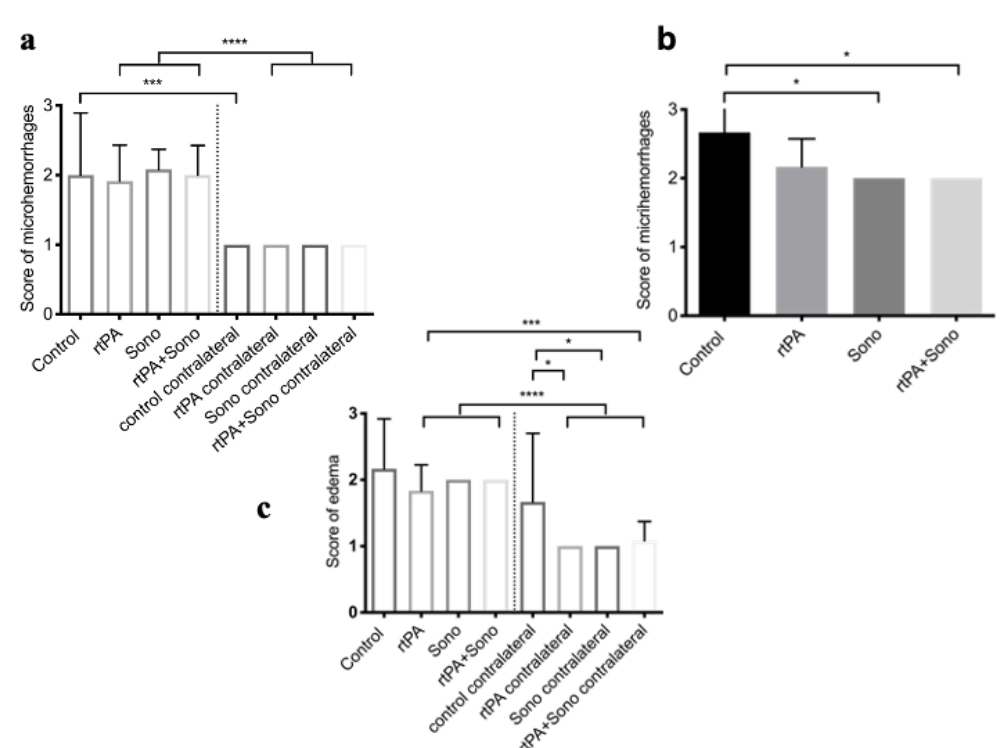
Figure 5. Microhemorrhages and edema using HE-staining (control Group n = 3; treatment groups (2–4); each n = 6). The means and SD of the score (1–3 points) of microhemorrhages or edema ( y -axis) ipsilaterally and contralaterally to ICH or perihematomal (area 1) ( x -axis) are plotted as a column bar graph. ( a ) **** marks the significant difference in the microhemorrhage-score of p < 0.0001 between the ipsilaterally and contralaterally brains of the ICH of the treatment groups (2–4). *** marks the significant difference of p = 0.0002 between the ipsi- and contralaterally brains of the control Group. ( b) Perihematomal (area 1): * marks the significant difference of the control compared to Group 3 and 4 of p = 0.0258. ( c ) **** marks the significant difference of p < 0.0001 between the ipsilaterally and contralaterally brains of the treatment Groups (2–4). *** marks the significant difference of p = 0.0001 between the ipsilaterally Group 2 and the contralaterally Group 4. * marks the significant difference between the contralaterally control Group and the contralaterally Group 2 and 3 ( p =